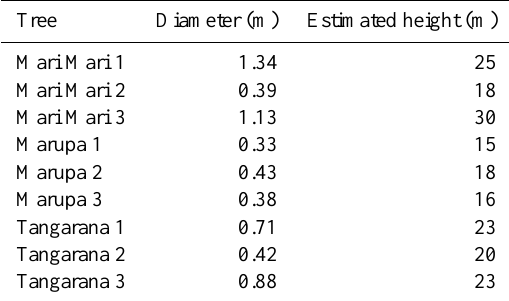
Table 1. Trees dimensions.